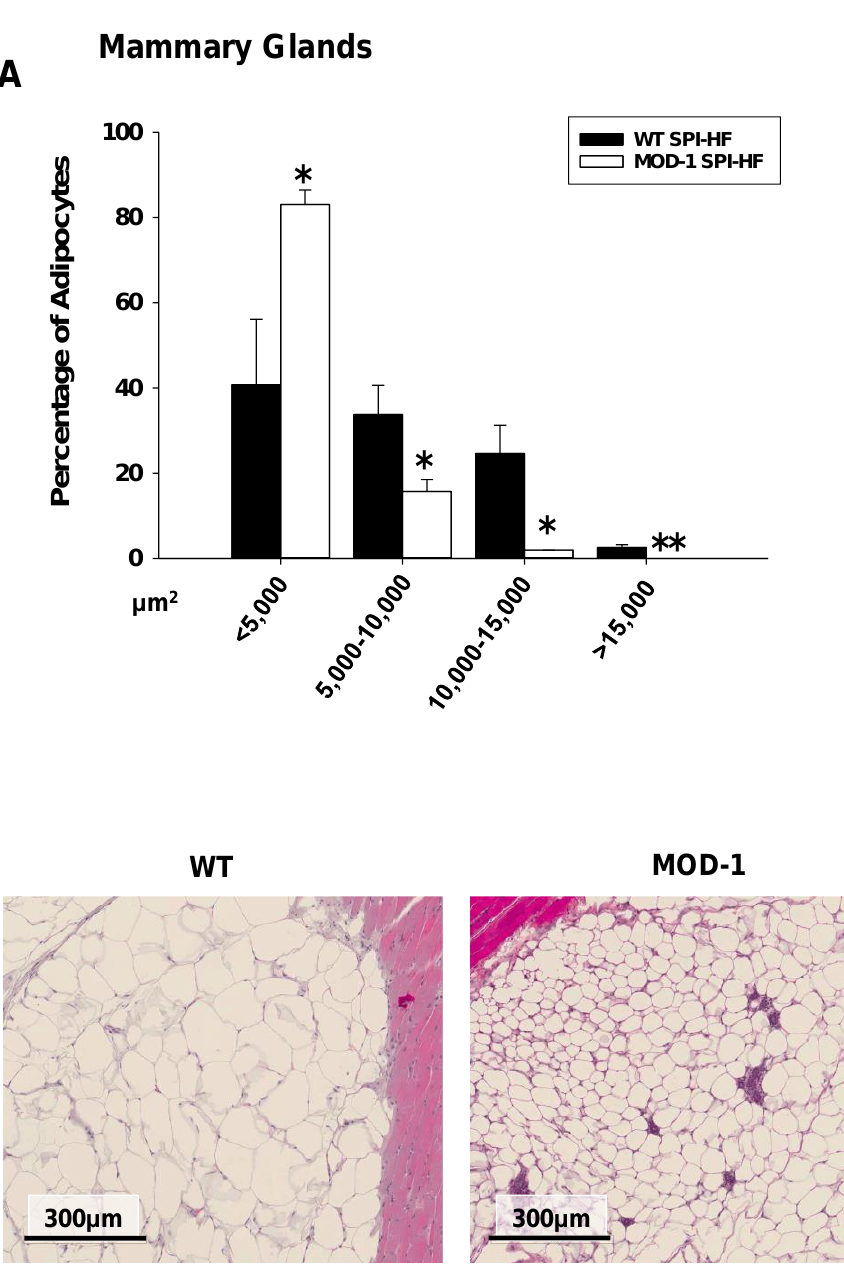
Figure 7. Adipocyte sizes (diameters) in mammary gland fat pads of female WT ( n = 4) and MOD-1 ( n = 4) mice who were fed a SPI-HF diet. ( A ) Me1 mutation led to a shift to smaller sizes of adipocytes; diameters in µm; mean ± SD. * p < 0.05, ** p < 0.01. ( B ) Representative section (H&E stained) of a mammary gland fat pad from one mouse of each genotype.